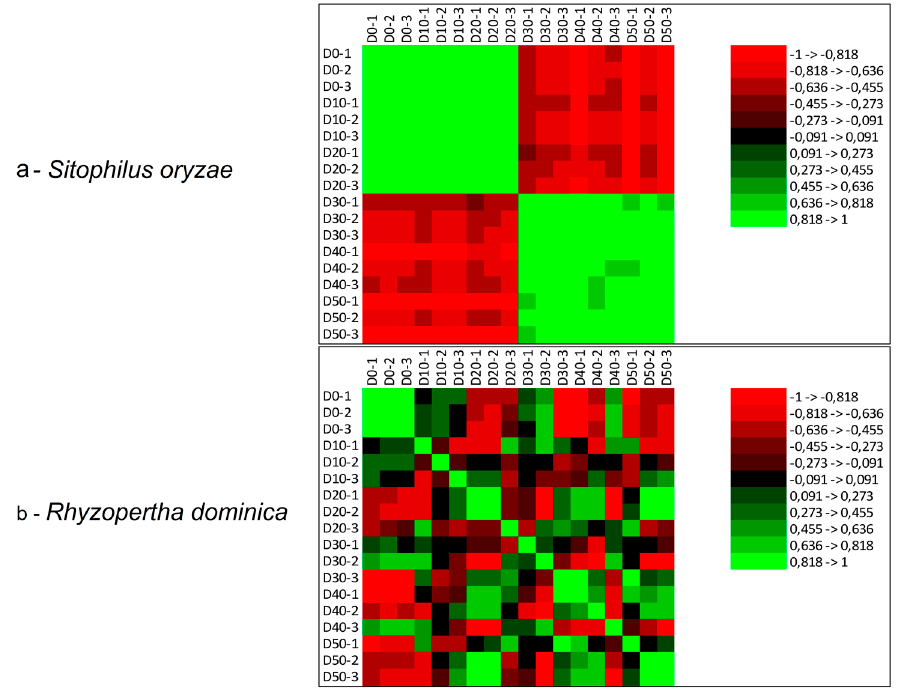
Figure 5. Heatmap based on cumulative correlation matrix (Pearson) of lethal test and bacteria CFU values (( a ): S. oryzae , ( b ): R. dominica ).